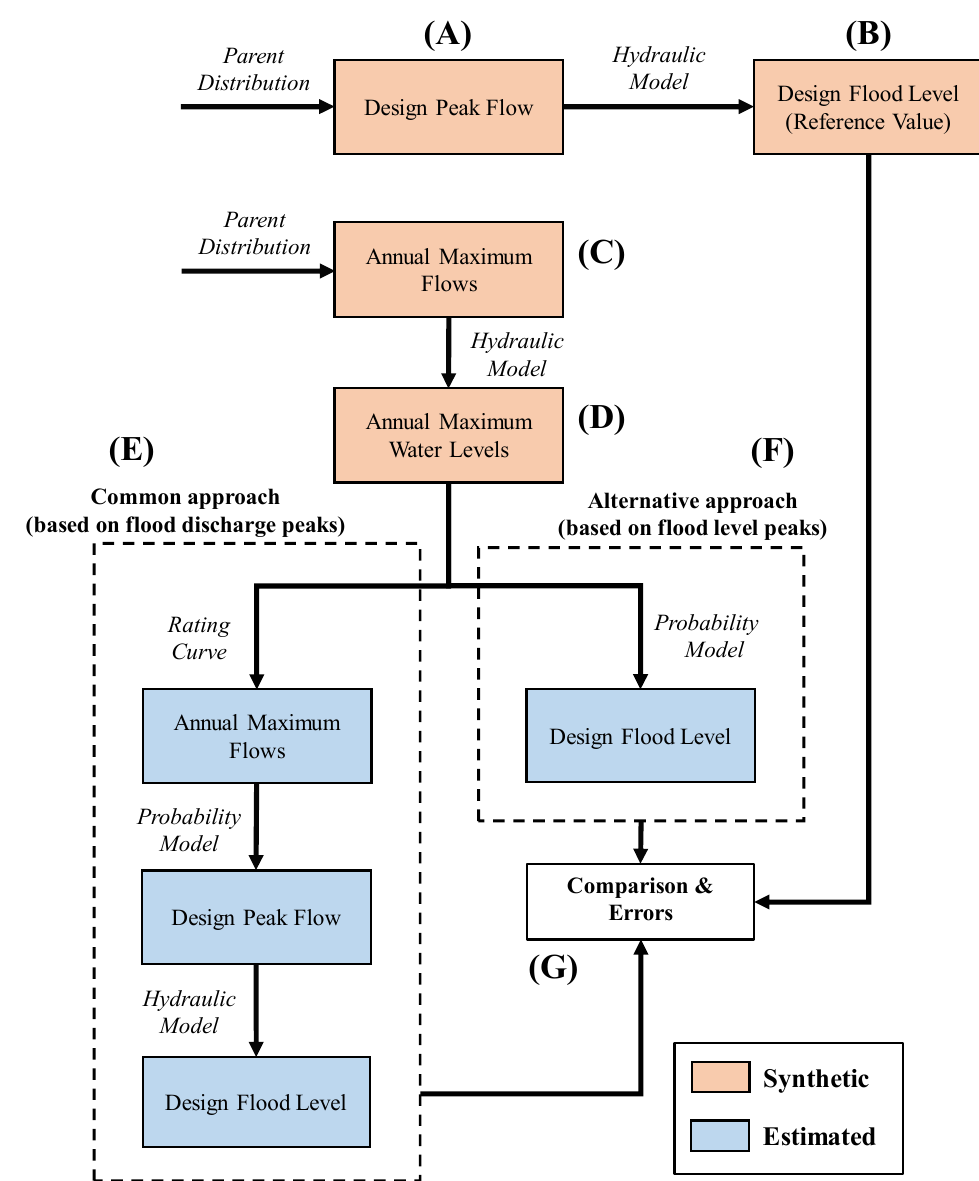
Figure 1. Virtual experiment proposed in this study. Graphical representation of the simulation framework to compare the estimation of design flood levels based on two alternative approaches.